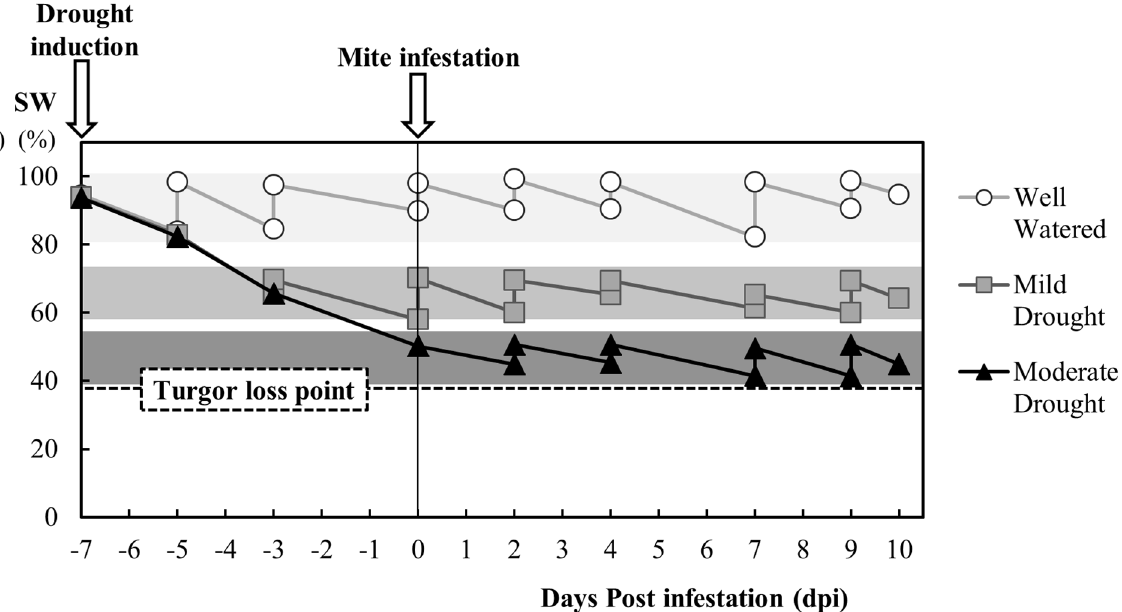
Fig 1. Water stress status (well watered, mild and moderate drought) of tomato plant. Drought induction was started 7 days before mite infestation and was continued until the end of the experiment [10 days post infestation (dpi)]. It is expressed as percentages of saturation weight (SW) and volumetric soil water content ( Ɵ ). The turgor loss point was established as 40% of